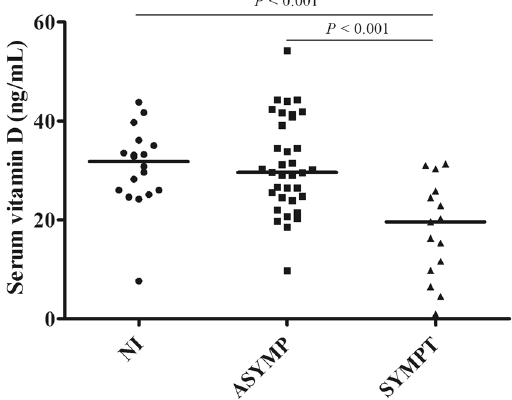
Figure 1. Serum vitamin D levels in dogs living in Mallorca and included in the study. Vitamin D status in dogs was assessed according to the serum levels of 25-hydroxyvitamin D (25(OH)D) estimated with an ELISA test. Non-infected dogs (NI), Leishmania -infected asymptomatic animals (ASYMP), and dogs clinically ill